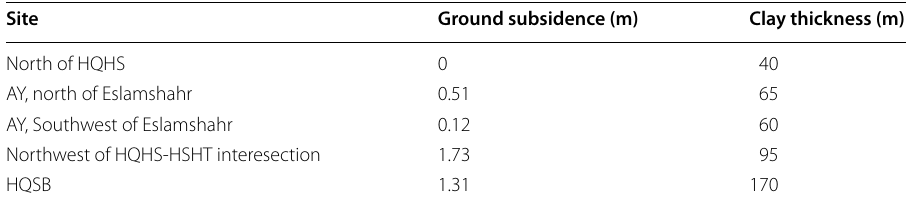
Table 2 Ground Subsidence and clay thickness measurements in some locations